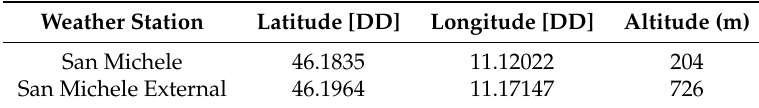
Figure 13. Geographical view of San Michele weather station (right pin) and San Michele External zone (left pin), where risk of infection has to be evaluated, geodesic distance of about 4.24 km. Table 4. Geographical coordinates of weather stations for Example 3